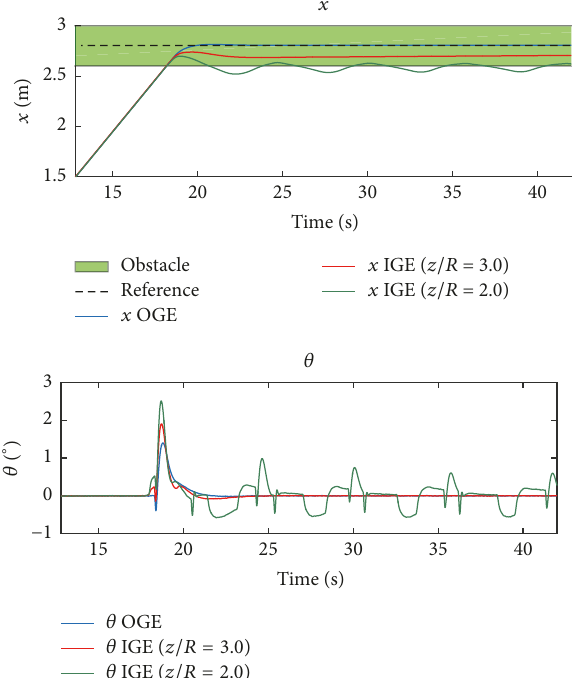
Figure 13: PID controller: hovering in partial ground